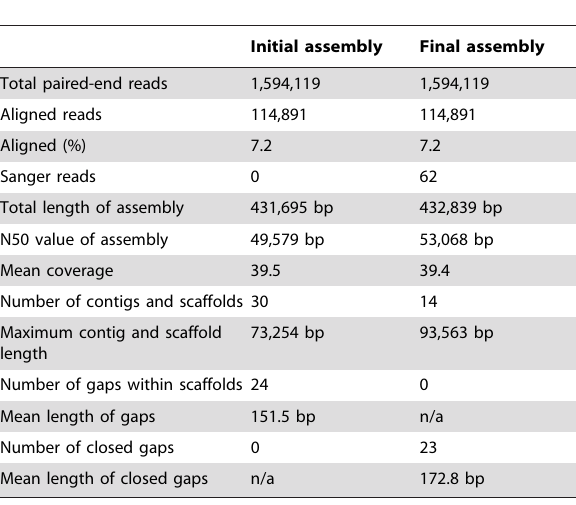
Table 2. Summary of the F. rimosivaginus mitochondrial genome sequencing and